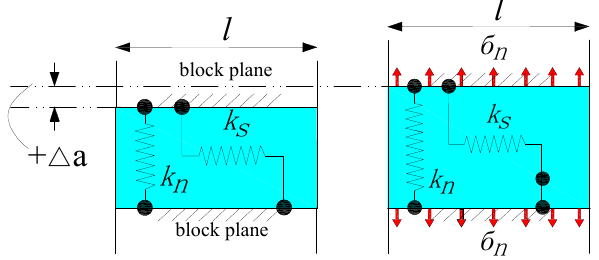
Figure 4. The contact hydraulic aperture.